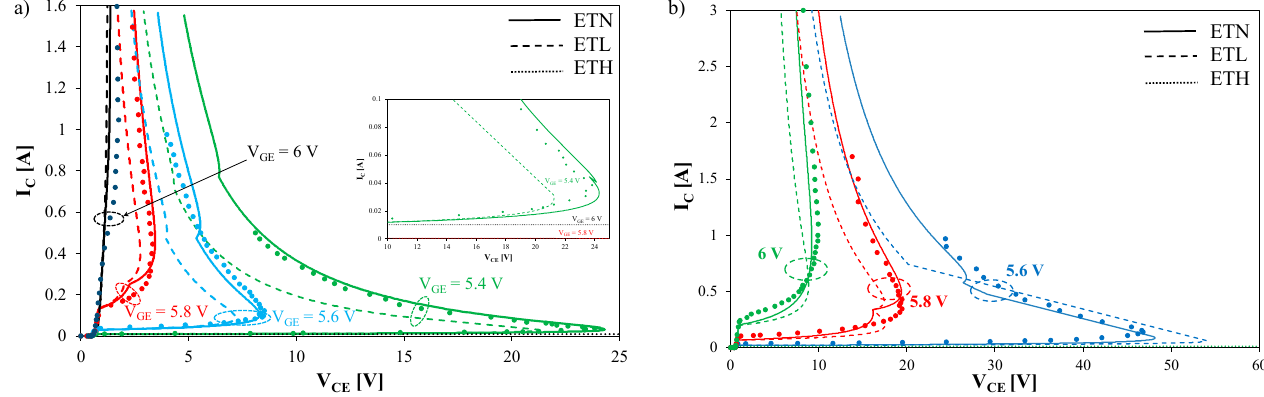
Figure 6. Computed and measured output characteristics at weak steering for the transistor operating without any heat-sink ( a ) and situated on the heat-sink ( b ).